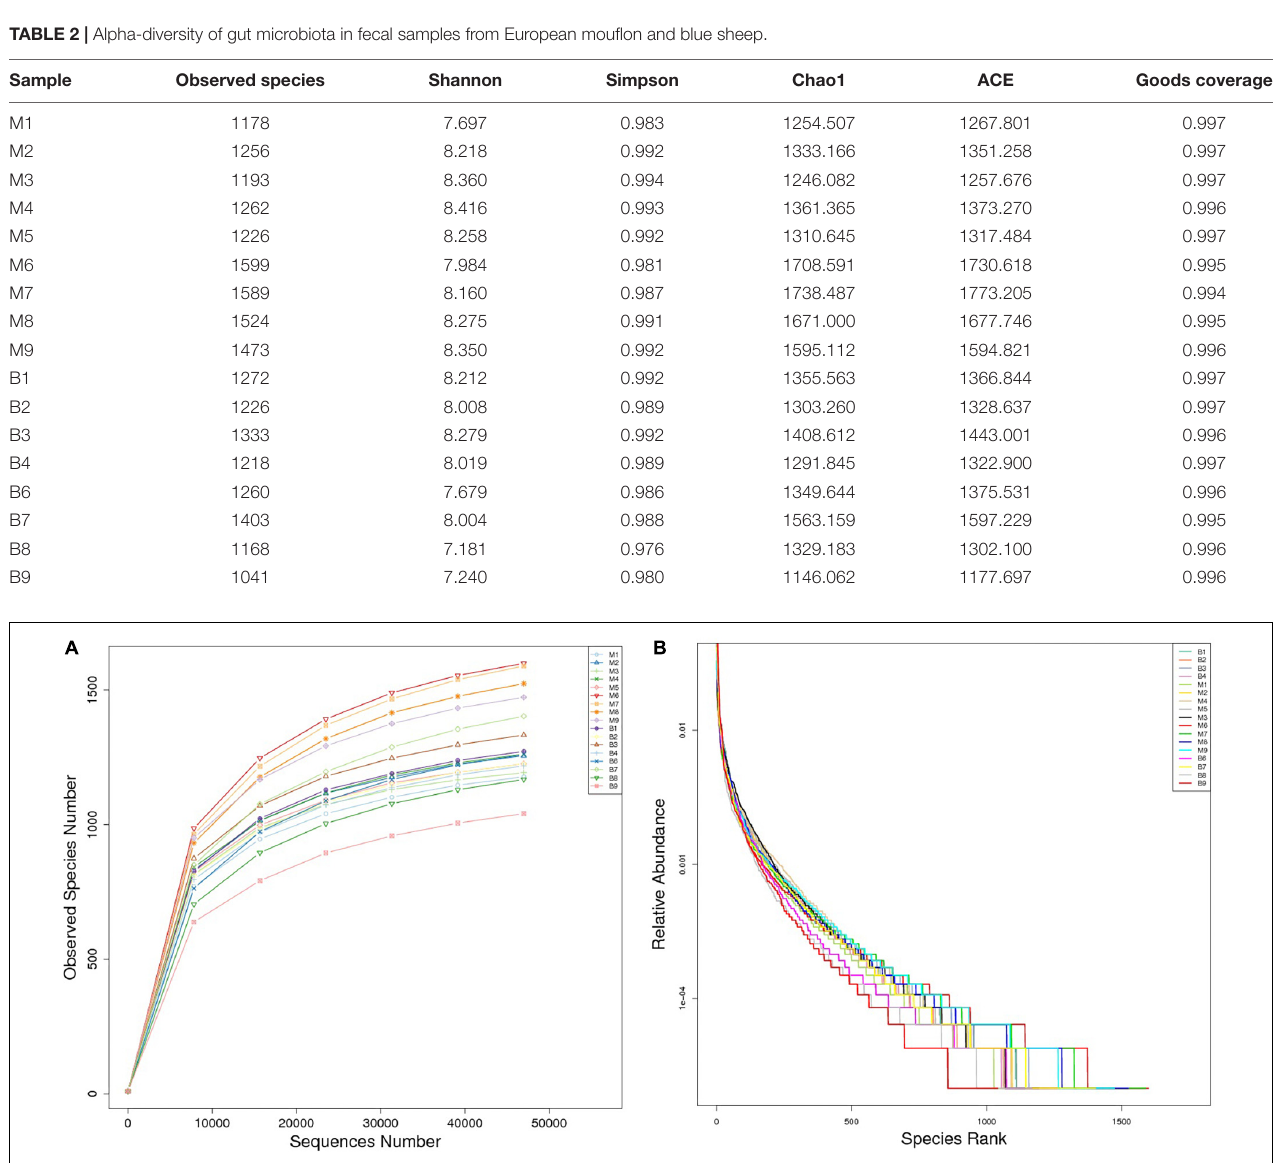
FIGURE 1 | Rarefaction curves (A) and rank abundance curves (B) of each sample. The saturated rarefaction curves and species richness indices indicate that the sampling was comprehensive. In rank abundance curves, a wider span of curves reflects a higher relative species abundance, and the smoother the curve on the y -axis reveals a higher evenness of bacterial species in the fecal samples of European mouflon and blue sheep.